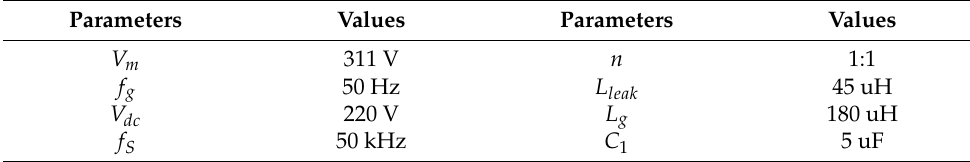
Table 1. Simulation parameters.